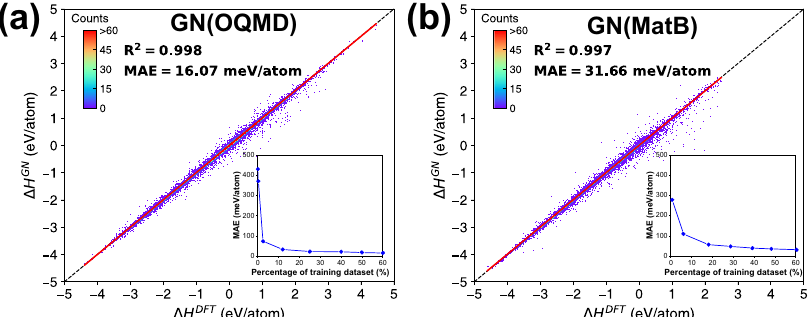
Fig. 2 The performance of GN model. GN-predicted and DFT-calculated formation enthalpies in a OQMD and b MatB. The mean absolute error as a function of percentage of training